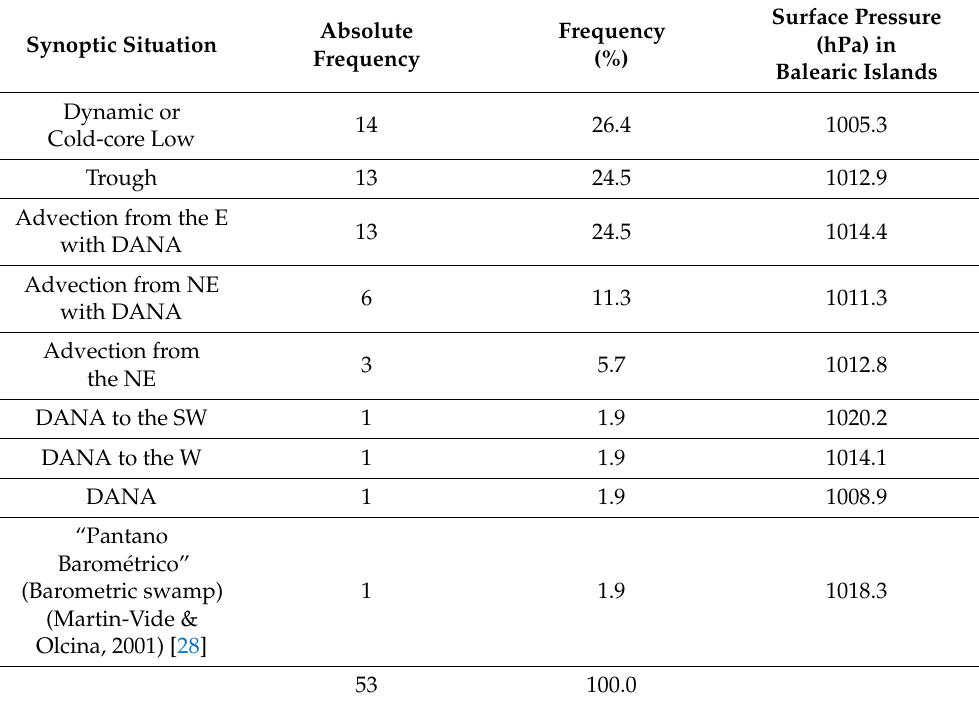
Table 3. Synoptic situation according to Martin-Vide’s classification [17] and surface pressure on days of torrential rain in the Balearic Islands